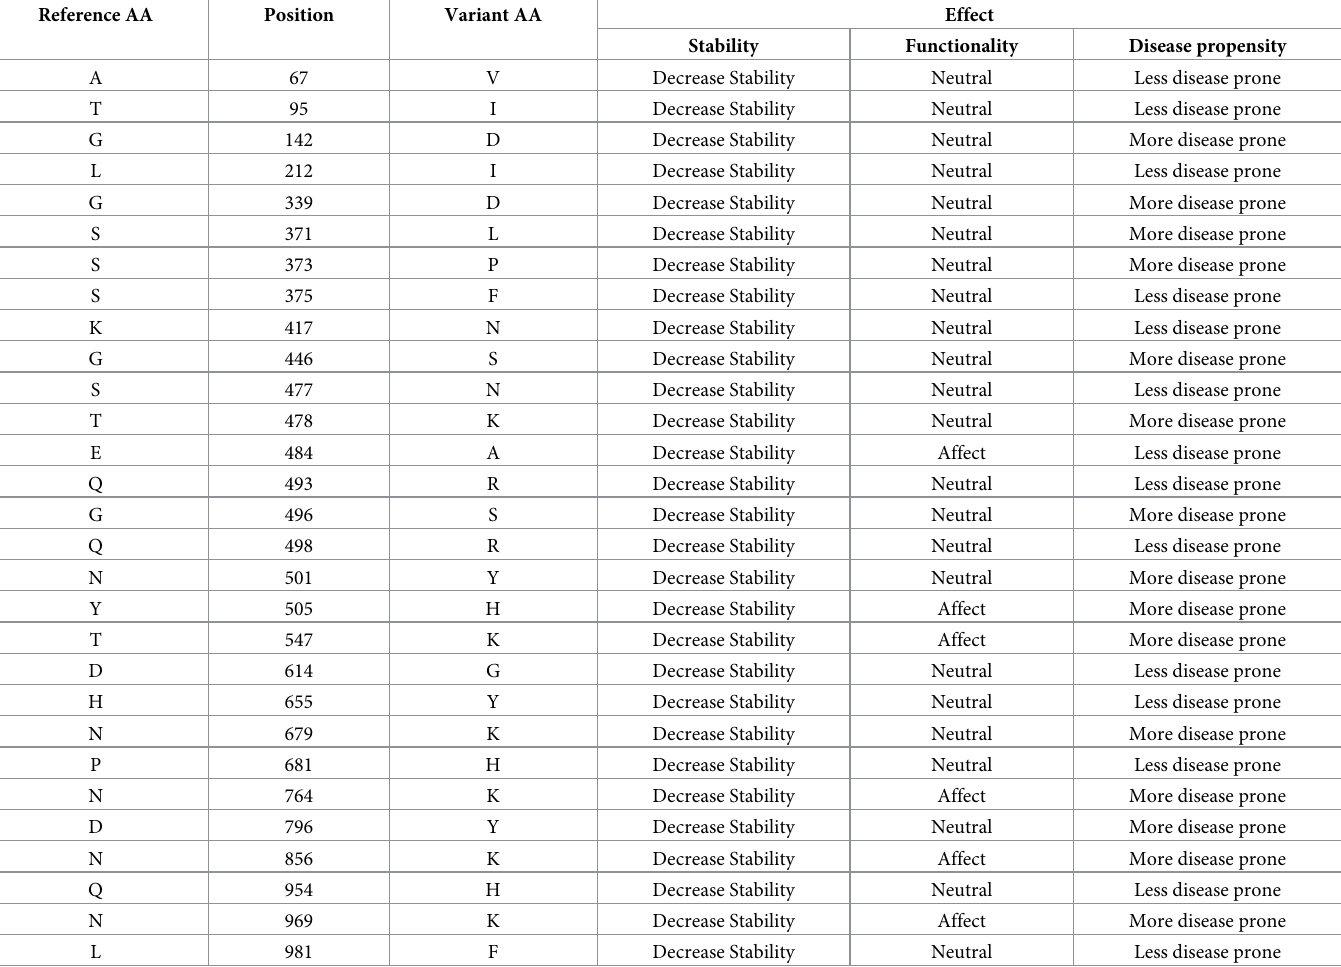
Table 3. The effects of mutations on the stability, functionality, and disease-proneness of the Omicron variant. Reference AA Position Variant AA Effect Stability Functionality Disease propensity 67 V Decrease Stability Neutral Less disease prone